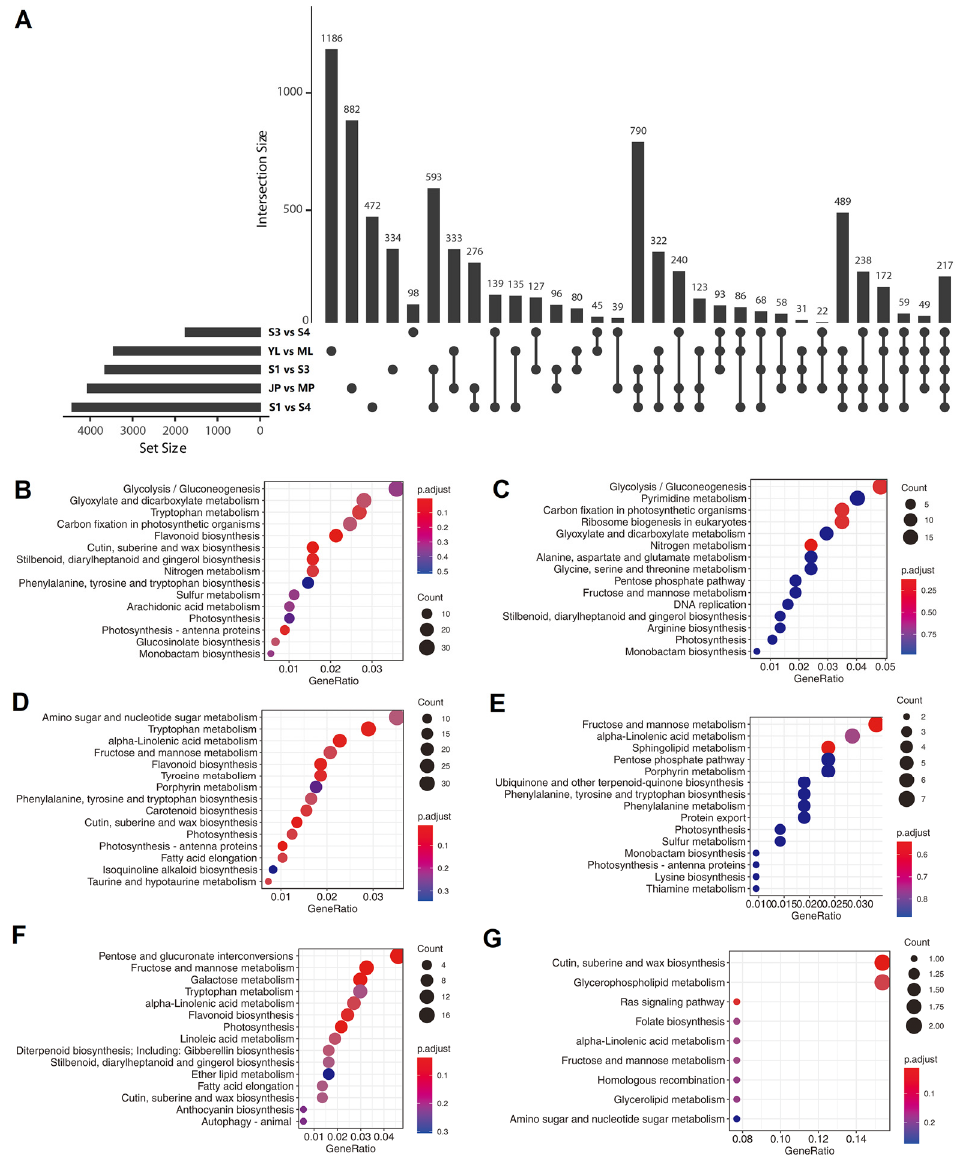
Figure 6. Functional annotations of differentially expressed transcripts (DETs). ( A ) Upset plot (an alternative Venn diagram) of differentially expressed transcripts. KEGG enrichment of all DETs of groups “YL vs. ML” ( B ), “JP vs. MP” ( D ), “S3 vs. S4” ( E ), and specific DETs of groups “YL vs. ML” ( C ), “JP vs. MP” ( F ), “S3 vs. S4” ( G ).